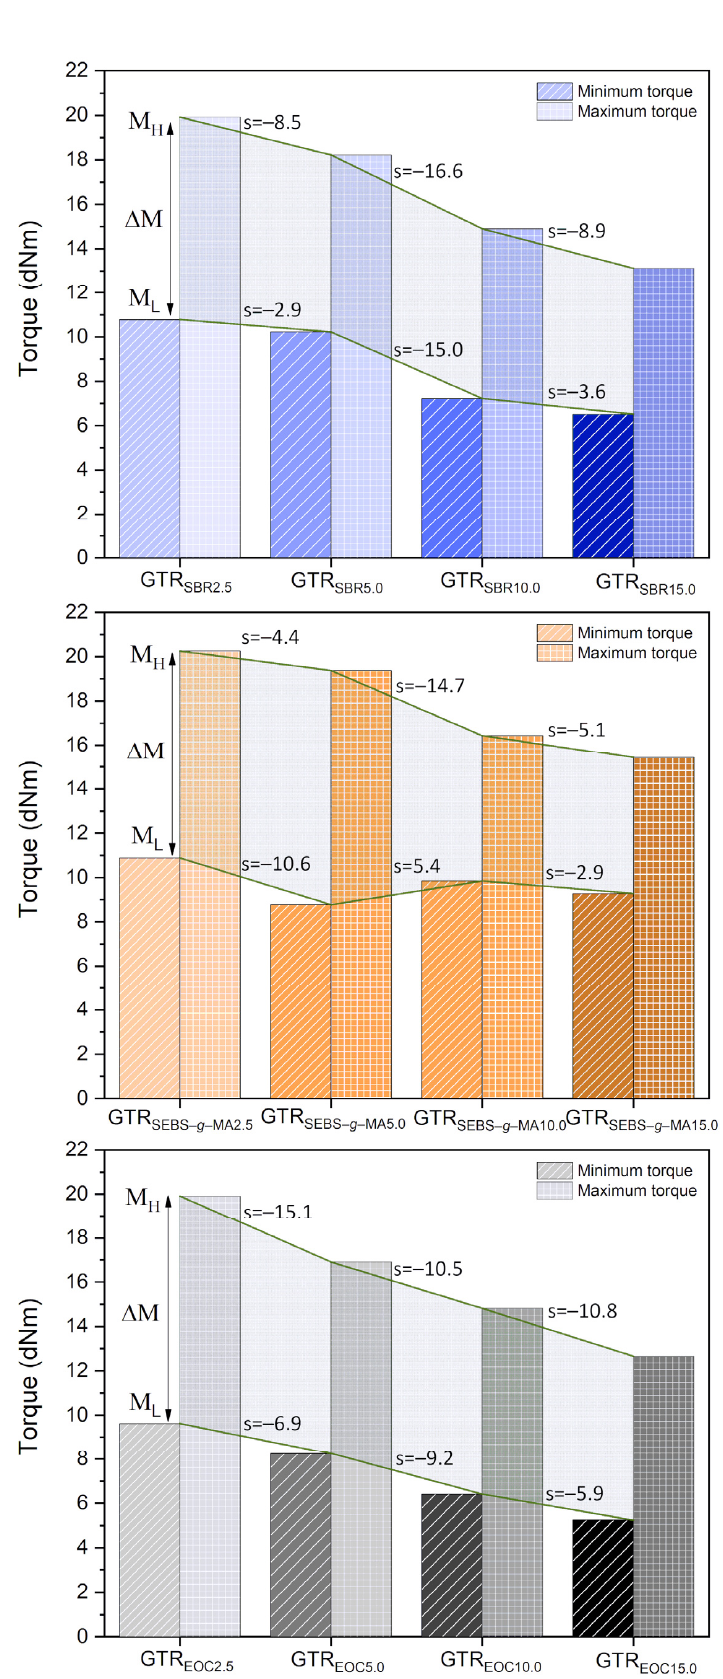
Figure 3. Torque parameter depending on the type and content of the modifier (curing characteristics at 170 °C).